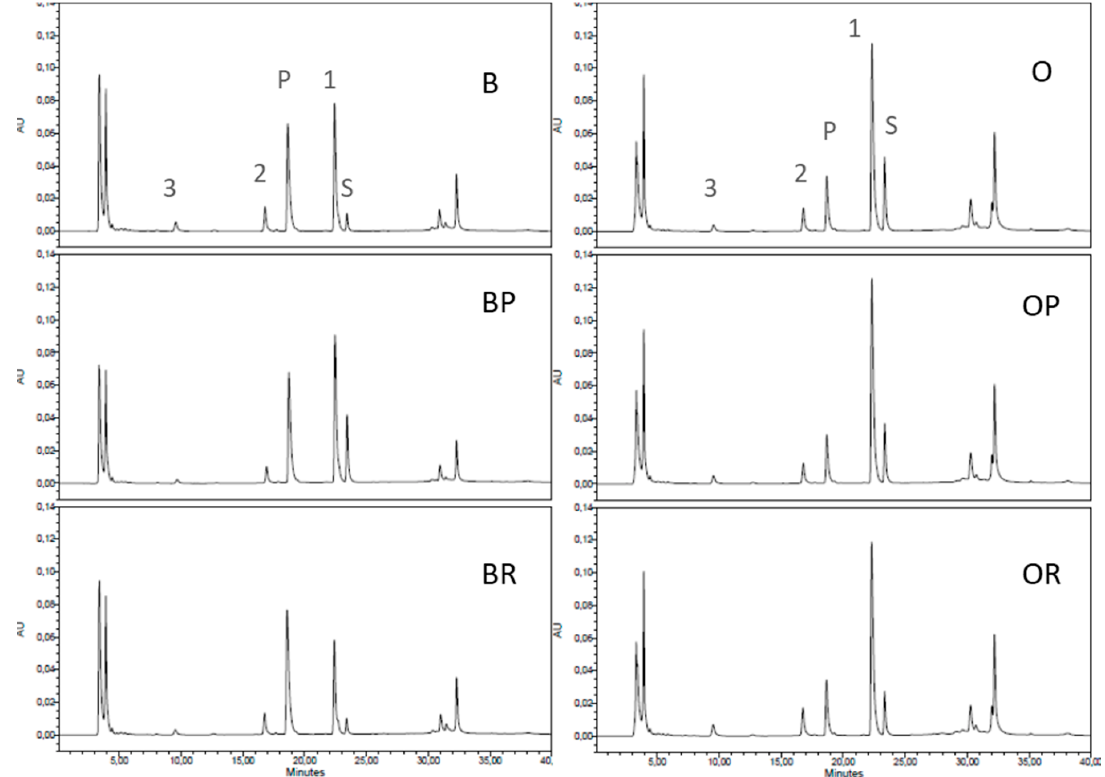
Figure 3. Proteinase activities in the acid whey fractions of feed bovine milk (B), bovine permeate (BP) and bovine retentate (BR), or feed ovine milk (O), ovine permeate (OP) and ovine retentate (OR), after incubation with the substrate Pro-Thr-Glu-Phe-[p-nitro-Phe]-Arg-Leu at pH 3.2 for 12 h at 37 °C. S: residual substrate; P: cathepsin D-like product; peaks 1, 2 and 3: other proteinases.